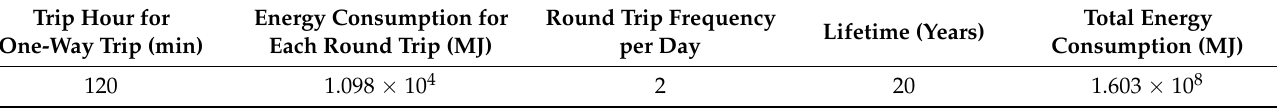
Figure 11. Operation profile of the 170 GT nearshore ferry. Table 3. Trip scenario of the 170 GT nearshore ferry.